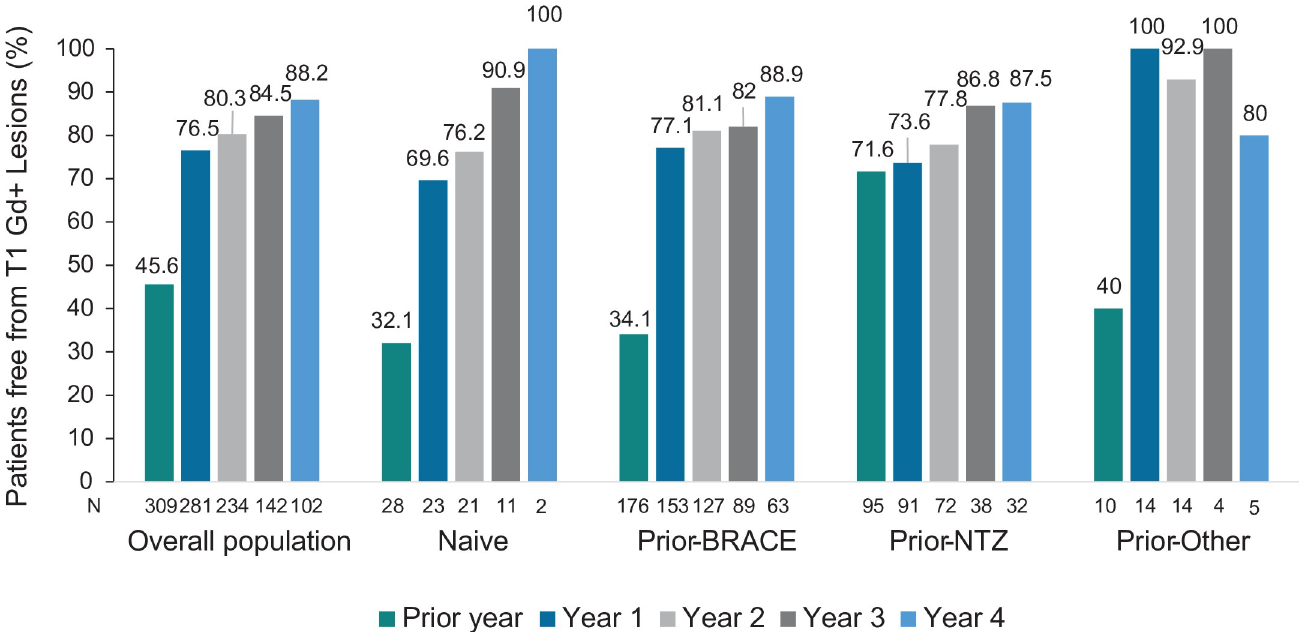
Fig 3. Patients free from T1 Gd+ Lesions in the overall population and prior treatment subgroups. Abbreviatures : BRACE: Betaseron (interferon beta-1b sc), Rebif (interferon beta-1a sc), Avonex (interferon beta-1a im), Copaxone (Glatiramer acetate), and Extavia (interferon beta-1b sc); EDSS, Expanded Disability Status Scale; IQR, interquartile range; N: Number of patients with available data for T1 Gd+ Lesions; NTZ, natalizumab.